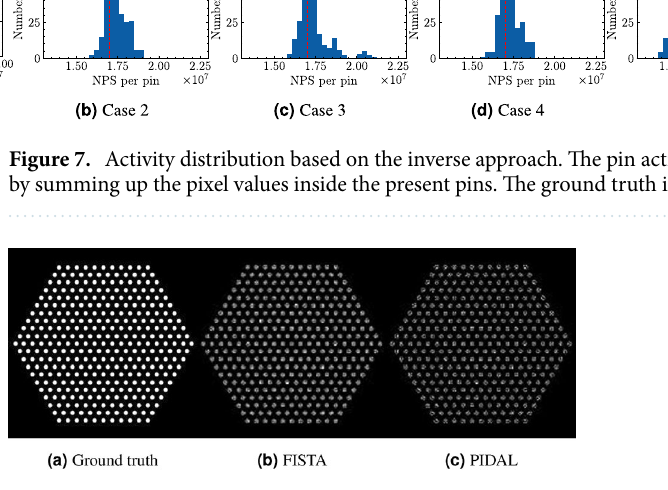
Figure 8. Comparison of FISTA and PIDAL reconstruction to the ground truth. The two methods led to visually similar results, though the PIDAL reconstruction resulted in a sparser image, compared to